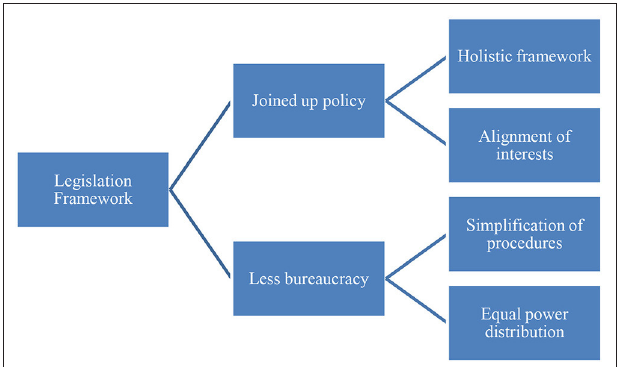
FIGURE 2 | Cluster policy: visualization of concept for legislation